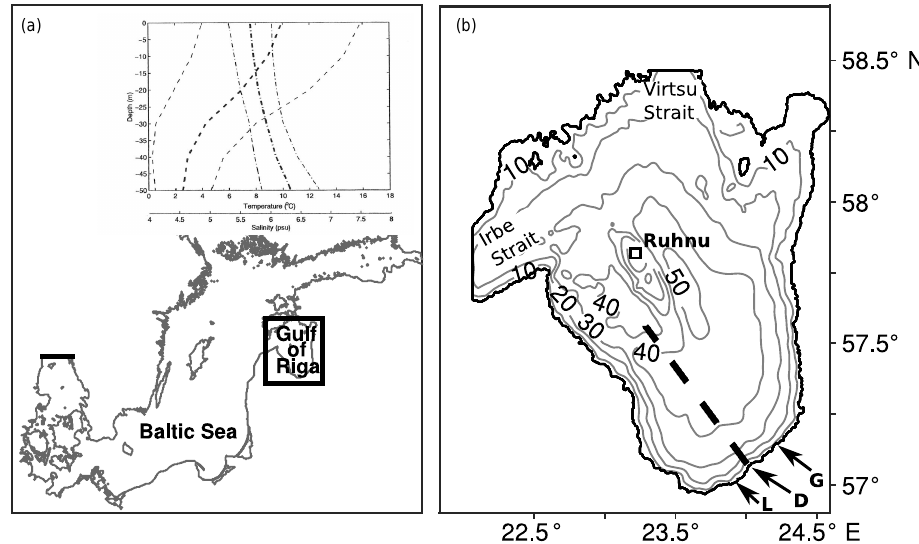
Figure 1. Map showing the location of the Gulf of Riga in the Baltic Sea (a) . Embedded are mean (bold) temperature (dashed) and salinity (dash dotted) profiles with standard deviations (thin) from the central Gulf of Riga (adopted from Raudsepp, 2001). Topography of the Gulf of Riga (b) . Arrows mark river mouth locations for the Daugava (D), Lielupe (L) and Gauja (G) rivers. The square shows the location of the weather station. The bold dashed line shows the transect of ferry-box measurements used for the model validation.